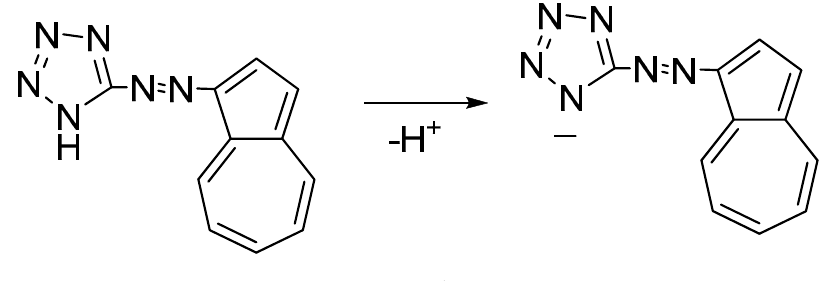
Figure 7. Tetrazole ionization.